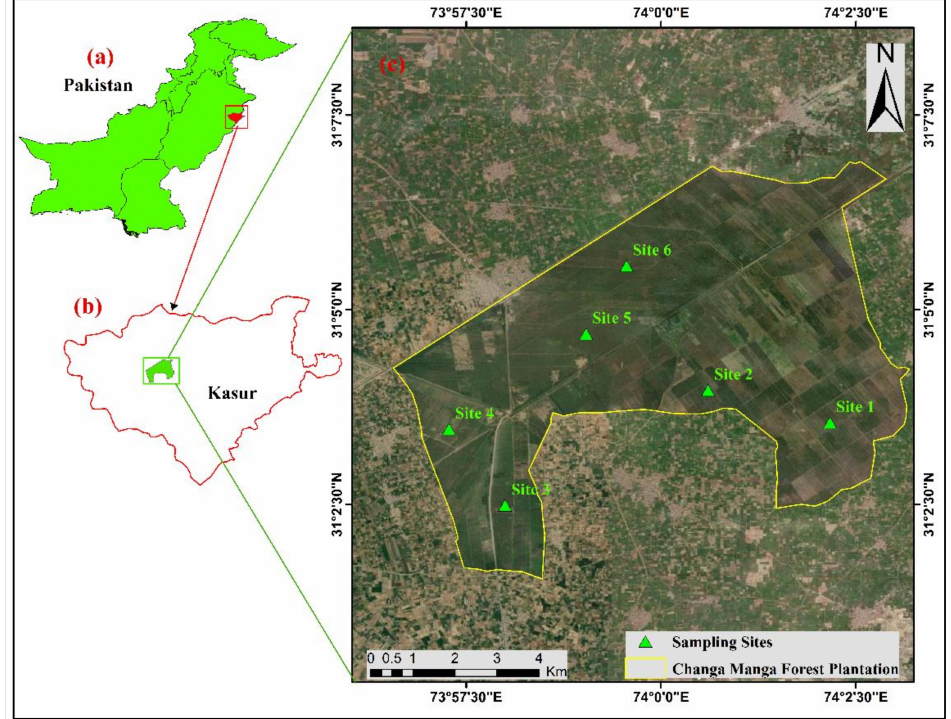
Figure 1. Map of the study area: ( a ) Pakistan, ( b ) District Kasur, ( c ) points showing the sampling sites of the Changa Manga Forest plantation and the sampling design used to collect